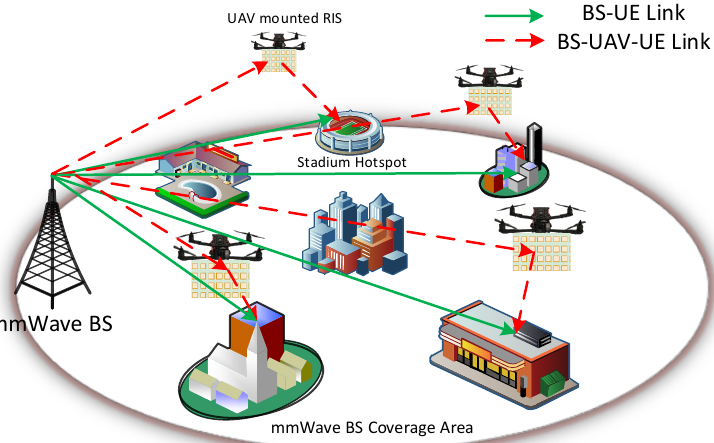
Figure 1. Proposed system model of multi mmWave UAV mounted RIS hotspot area